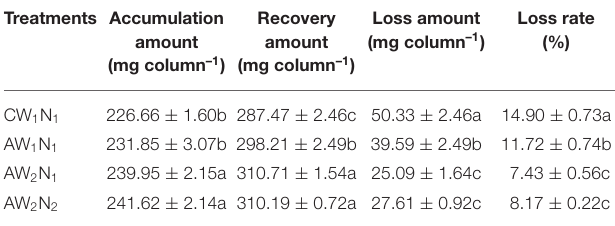
TABLE 4 | The effects of irrigation and N treatments on 15 N accumulation and recovery and 15 N loss from the top 0–100cm soil layer under alternate partial root-zone drip N